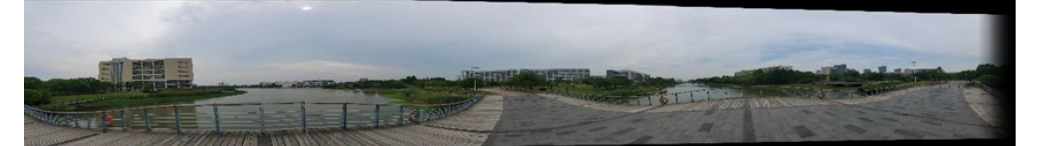
Figure 10. The result of stitching based on the binary tree model.